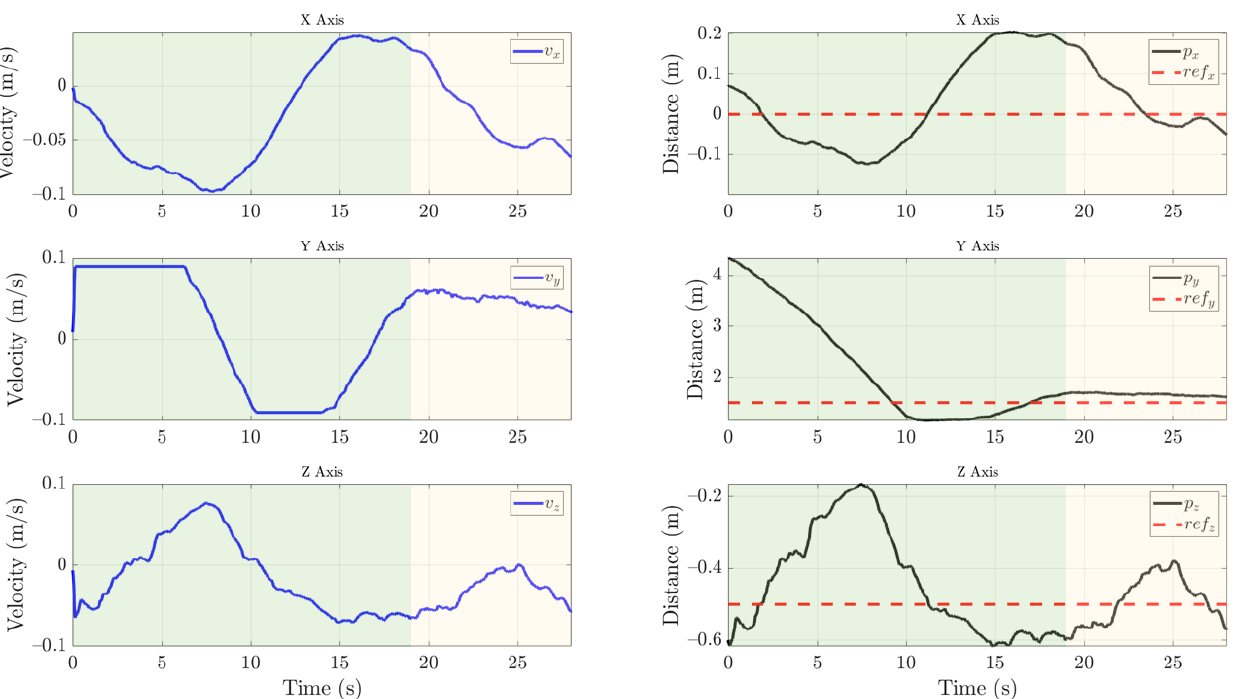
Figure 13. Visual control of the UAV with the control signal ( blue line ), position estimation of the insulator ( black line ), and reference ( dotted red line ). Once the insulator is detected, the UAV performs the approach phase indicated by the green area. When the UAV is stabilized on the three axes below a threshold for three seconds, the cleaning phase indicated by the yellow area